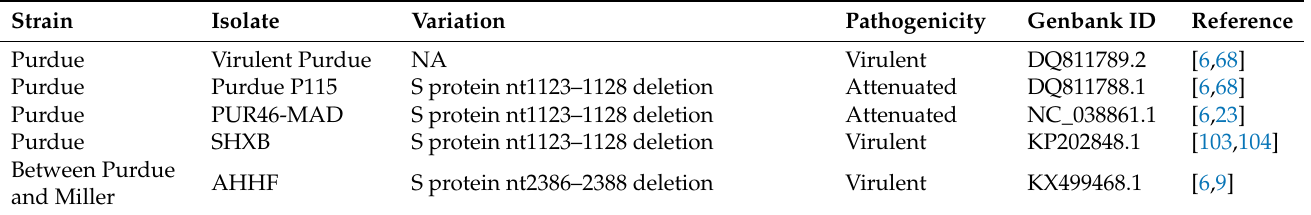
Table 1. Representative strains, classic variation, and pathogenicity of each TGEV